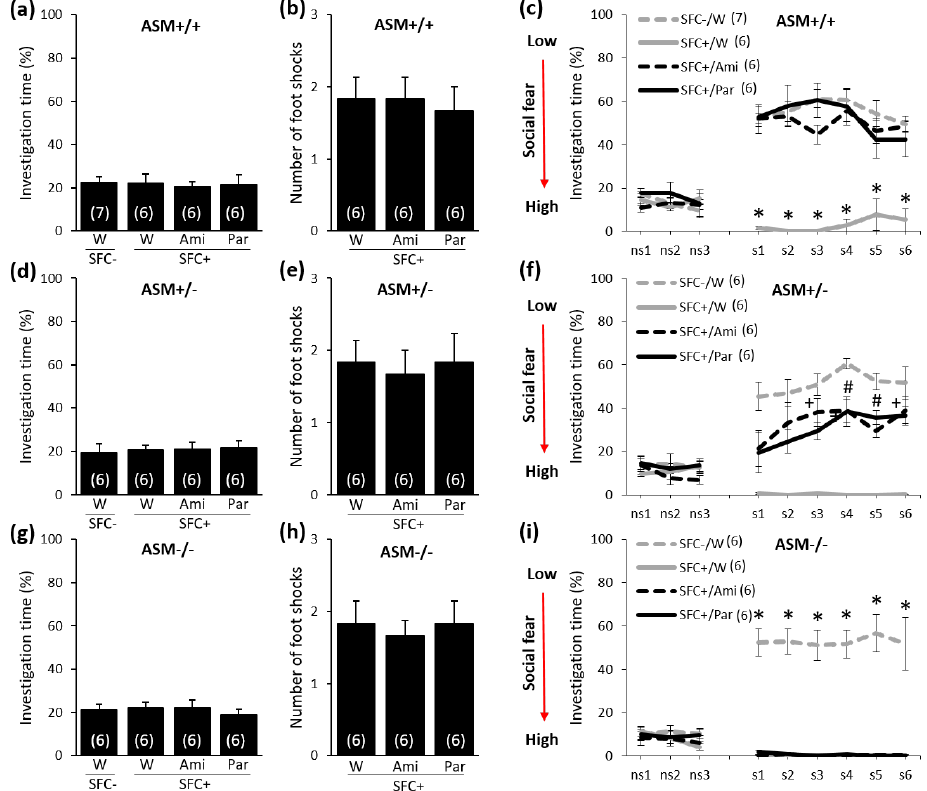
Figure 2. Chronic paroxetine (20 mg/kg/day for 28 days) or amitriptyline (180 mg/L for 28 days) treatment reduces social fear in ASM+/+ and ASM+/− mice but not in ASM−/− mice. ( a , d , g ) Preconditioning investigation of the non-social stimulus (empty cage) shown by unconditioned (SFC − ) and conditioned (SFC + ) mice during SFC on day 1. ( b , e , h ) Number of foot shocks received by SFC + mice during SFC. ( c , f , i ) Investigation of the non-social (ns1–ns3) and social (cages with mice, s1– s6) stimuli during social fear extinction on day 30. Paroxetine (Par) or amitriptyline (Ami) were ± SEM, and numbers in parentheses indicate group sizes. p < 0.05 * versus all groups, # versus SFC − /W and SFC + /W, and + versus SFC + /W. 2.3. Acute NPY Treatment Reduces Social Fear in ASM+/+, ASM+/−, and ASM−/− Mice Given that i.c.v.-administered NPY (1 nmol/2 µL) reduced SFC-induced social fear in CD1 mice [22], we determined whether NPY could also reduce the antidepressant-resistant social fear in ASM−/− mice. For this, SFC + and SFC − ASM−/−, ASM+/−, and ASM+/+ mice were infused i.c.v. either with NPY or with a vehicle solution (Veh) 10 min before social fear extinction on day 16. During SFC on day 1, all mice showed similar preconditioning non-social anxiety before treatment (Figure 3a: F(2,15) = 0.418; p = 0.666, Figure 3d: F(2,21) = 0.060; p = 0.942, and Figure 3g: F(2,17) = 0.106; p = 0.900) and all SFC + mice received a similar number of foot shocks (Figure 3b: T(10) = −0.415; p = 0.687, Figure 3e: T(14) = −0.323; p = 0.751, and Figure 3h: T(12) = −0.408; p = 0.690). On day 16, during social fear extinction, all SFC + and SFC − mice showed similar non-social investigation (Figure 3c,f,i), which indicates that SFC did not induce unspecific non-social fear. While all vehicle- treated SFC + mice showed high levels of social fear, NPY reduced social fear in ASM+/+ mice (Figure 3c; stimulus x group effect F(16,120) = 13.627; p < 0.001), ASM+/− mice (Figure 3f; stimulus x group